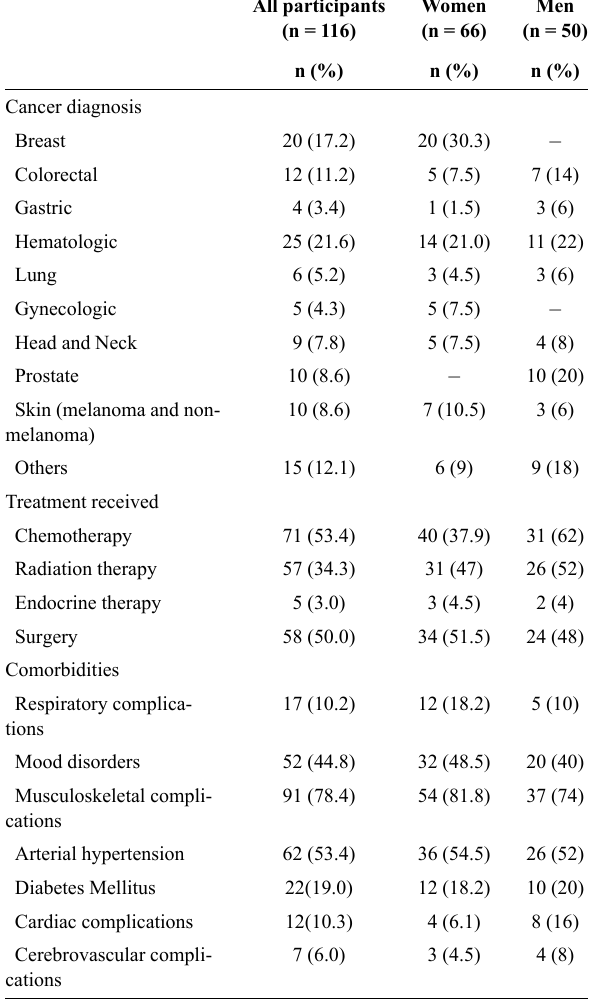
Table 2 - Cancer diagnosis, stage, and